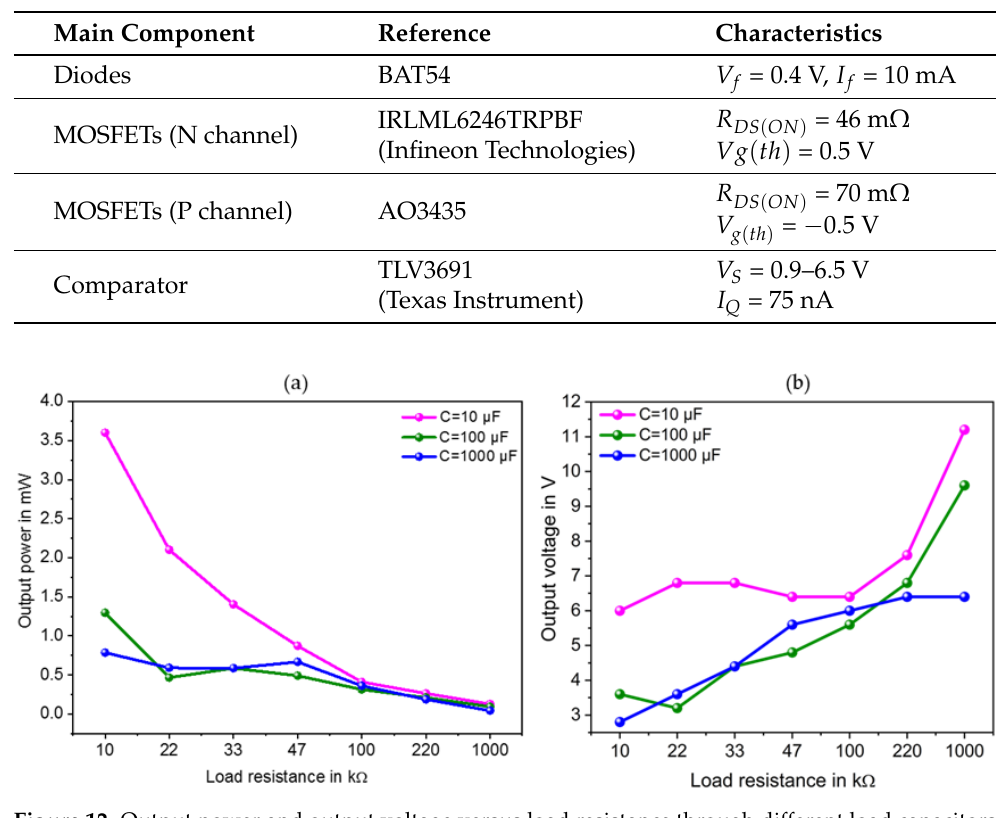
Figure 12. Output power and output voltage versus load resistance through different load capacitors ( a , b ) for the proposed SP-PSSHI interface.